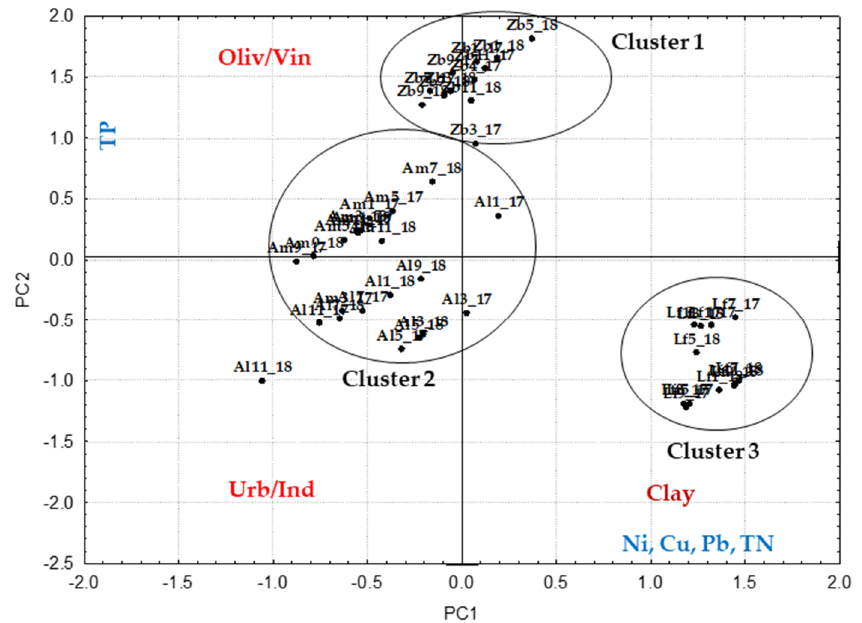
Figure 7. Scores of the sediments samples of streams, on the bidimensional plan defined by the first two principle components (PC) and parameters that most influence the explanation of each PC. At the figure are represented the statistically significant clusters obtained with the Euclidean distance of (Dlink/Dmax) × 100 < 50.